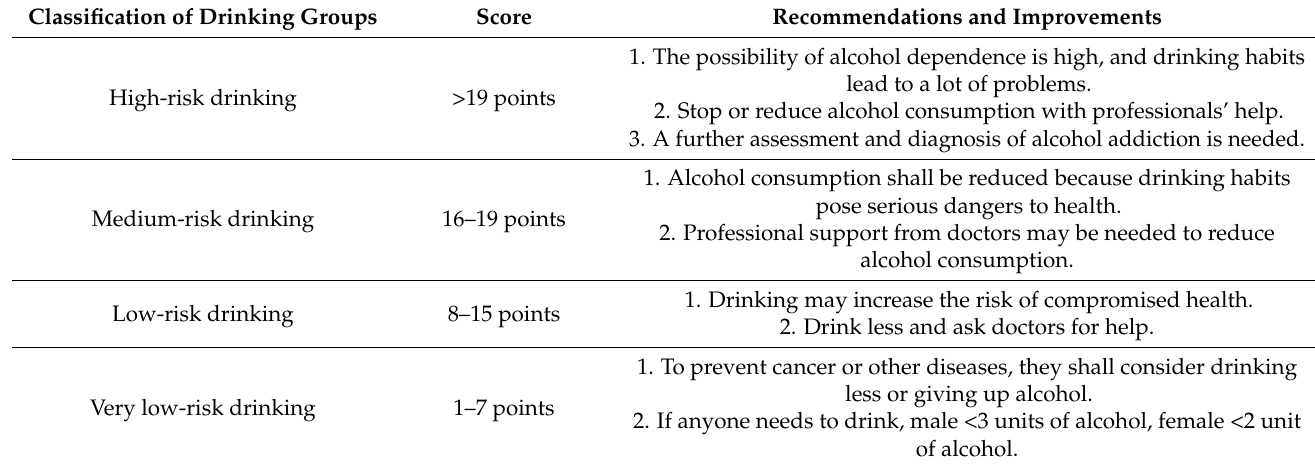
Table 1. AUDIT statistical scale and